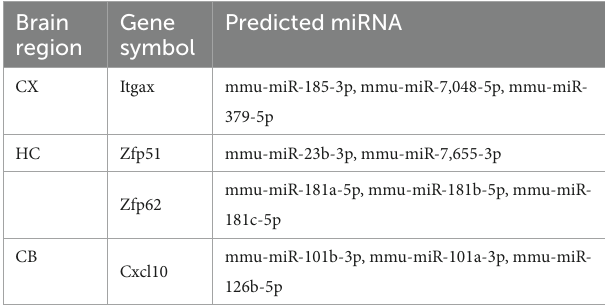
TABLE 6 Interaction between hub genes and